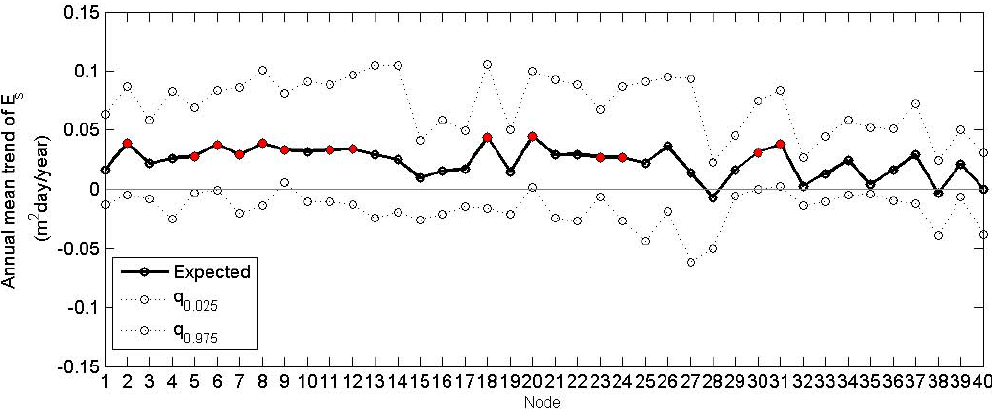
Fig. 10. Annual mean rate of increase/decrease of E s (slope between E s ( t =1958) and E s ( t =2001)) of storm events coming from S for all nodes along the Catalan coast (for the time period 1958–2001). In addition, their 95% confidence intervals are added and those nodes with detected trend by Mann-Kendall (MK) test are marked in red.